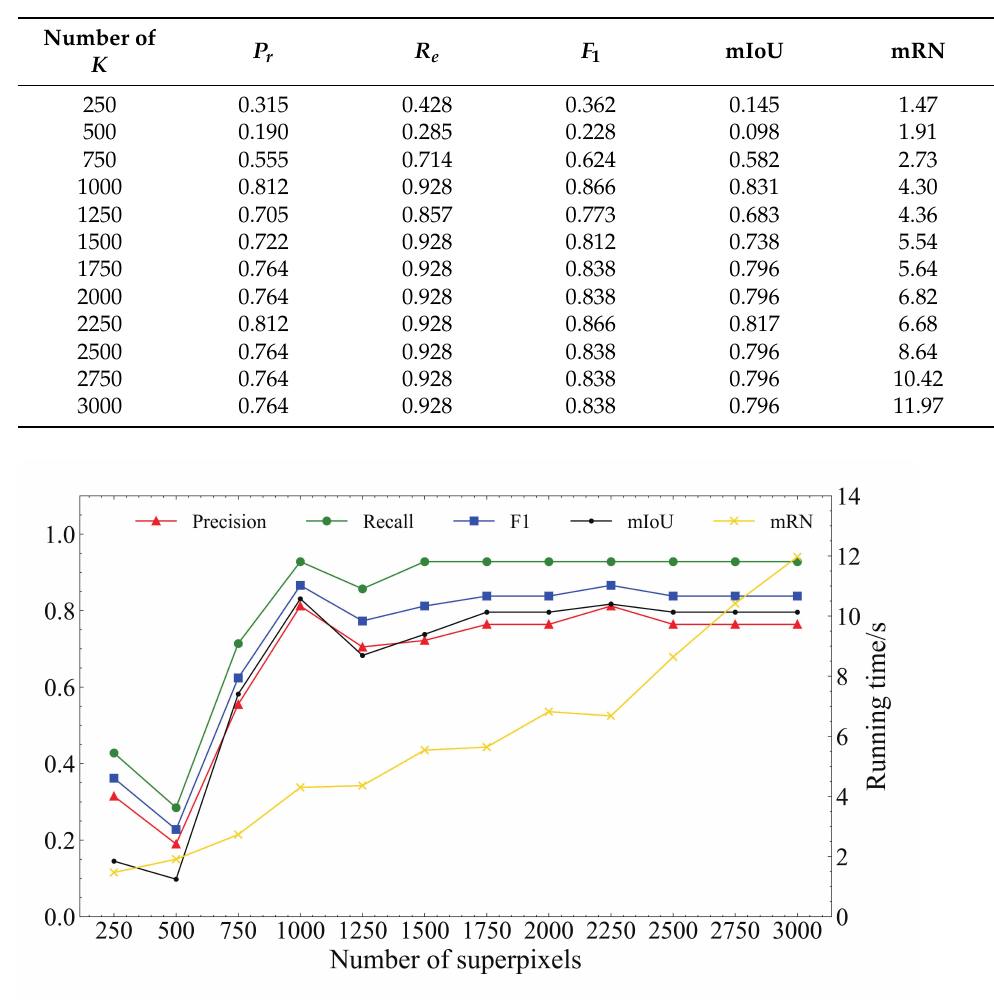
Figure 7. Results of ablation experiments on the number of superpixels.